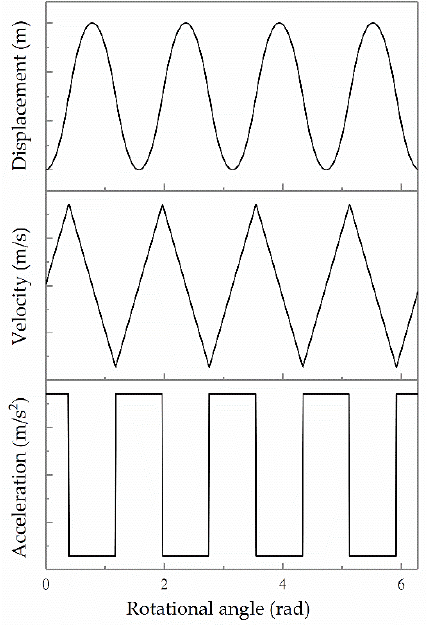
Figure 5. The motion law of the cam rail set.